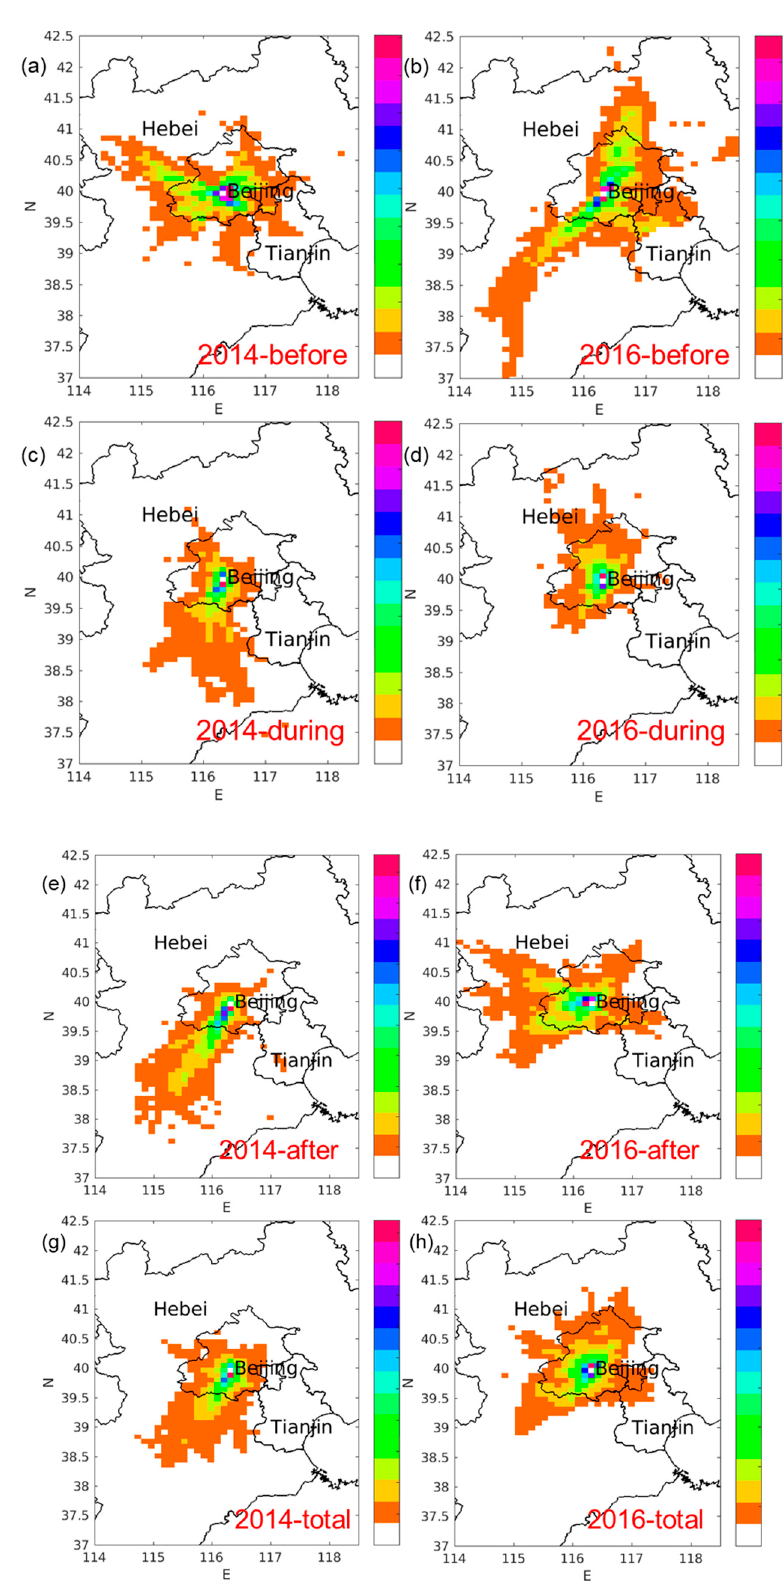
Figure 10. RTAs of four time periods (before, during, after, total) in 2014 and 2016. Subplots ( a , c , e , g ) are for the year of 2014 and ( b , d , f , h ) are for the year of 2016. From bottom to top side of the color bar, the cell contribution gets higher.